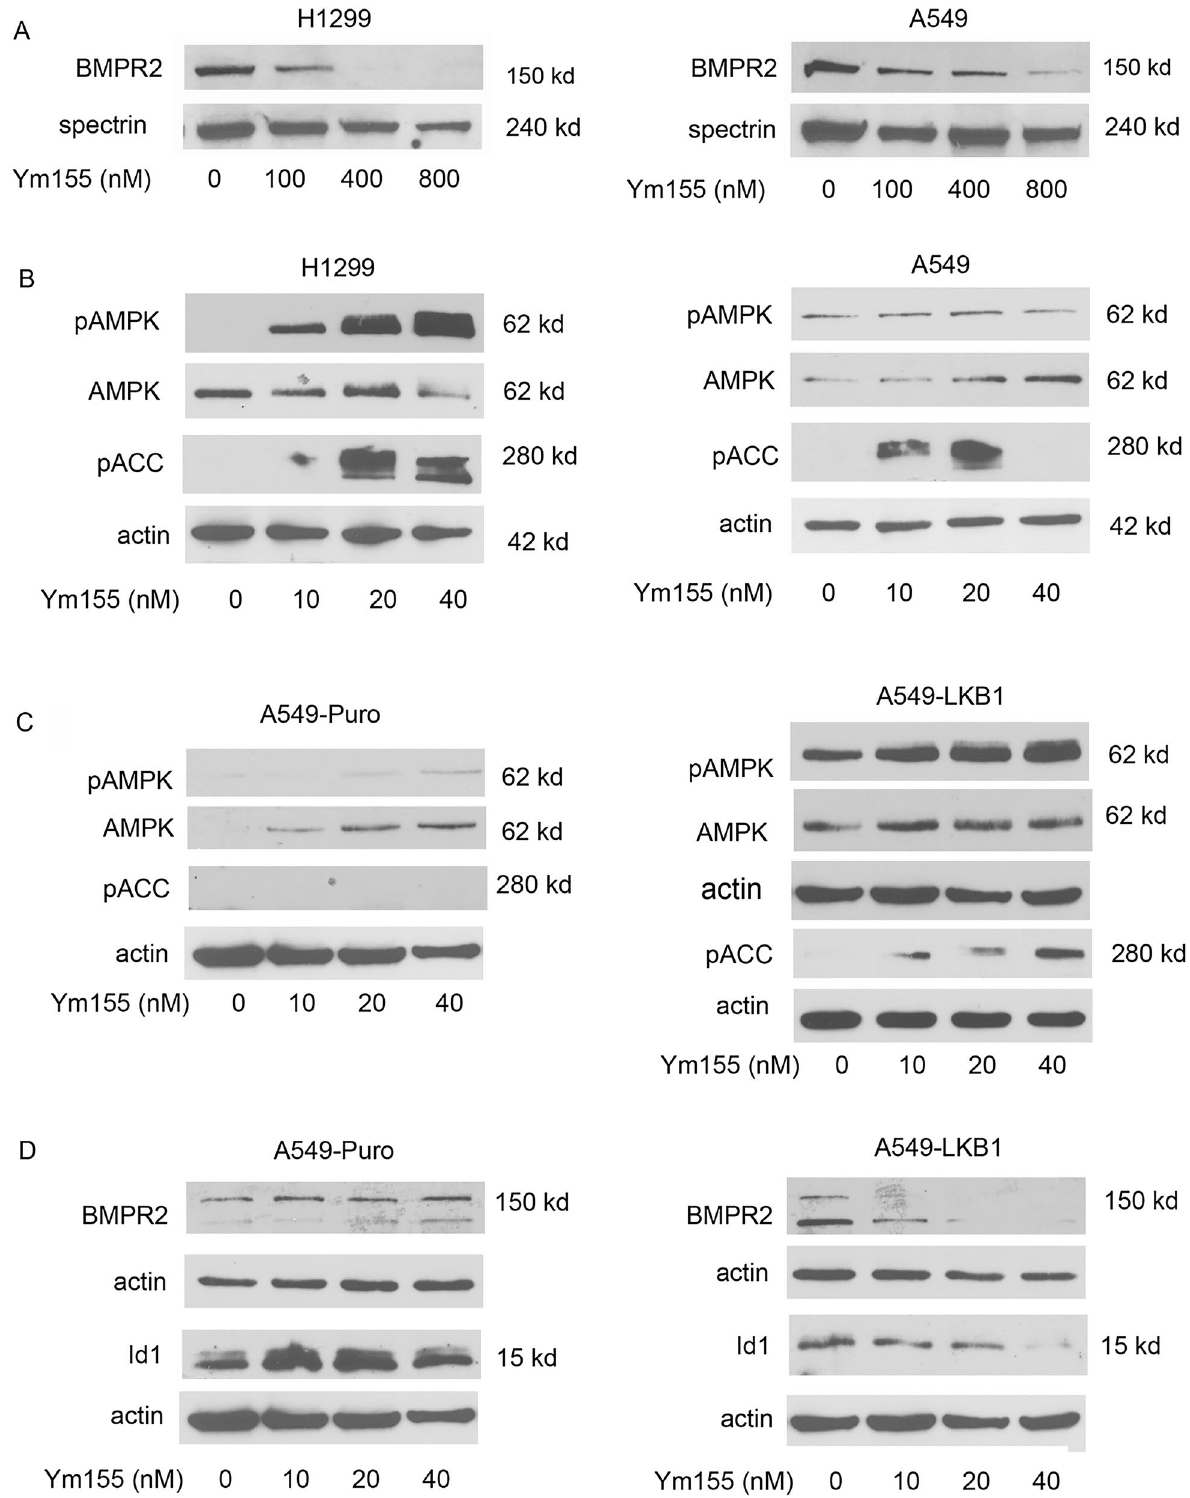
Figure 6. Ym155 activates AMPK and downregulates BMP signaling. ( A ) Immunoblot for BMPR2 in H1299 and A549 cells treated with Ym155 for 24 h. ( B ) Immunoblot for pAMPK (T172) and pACC (Ser79) of cells treated for 24 h. ( C ) Immunoblot for pAMPK (T172) and pACC (Ser79) of A549 control transfected cells (A549-puro) and A549 cells stably transfected with LKB1 (A549-LKB1) treated for 24 h. ( D ) Immunoblot of A549-puro and A549-LKB1 cells treated with Ym155 for 24